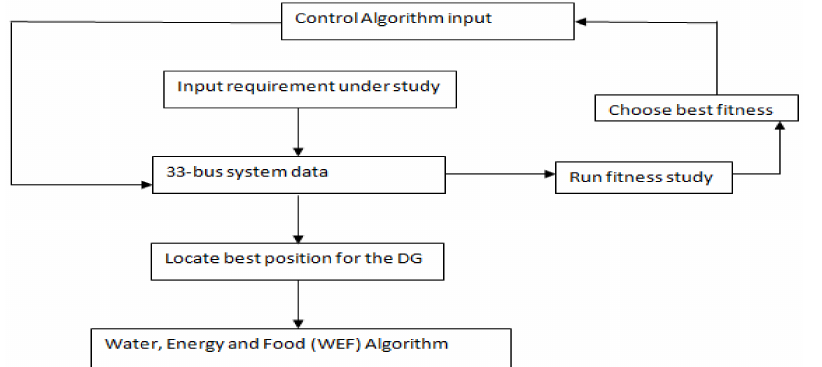
Figure 3. Block diagram for allocation of DG.